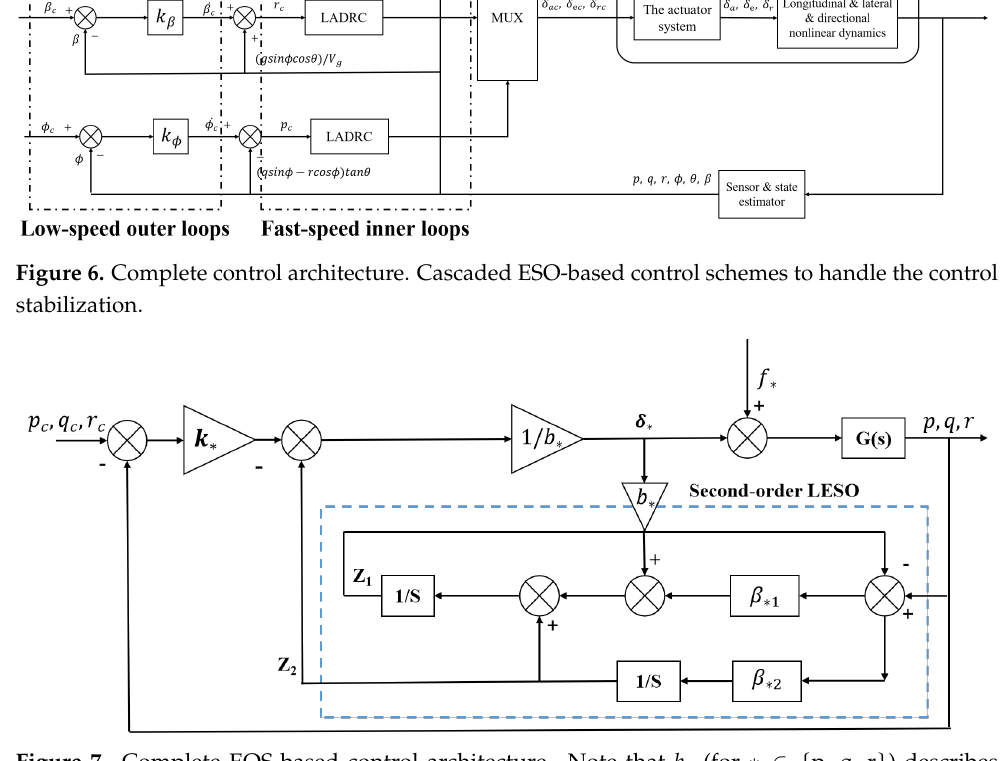
Figure 7. Complete EOS-based control architecture. Note that b ∗ (for ∗ ∈ { p, q, r } ) describes control efficiency related parameter. β ∗ 1 and β ∗ 2 (for ∗ ∈ { p, q, r } ) are ESO ralated parmeters. δ ∗ (for ∗ ∈ { a, e, r } ) is the actuator command. k ∗ (for ∗ ∈ { p, q, r } ) defines low-speed outer loop parameter. f ∗ (for ∗ ∈ { p, q, r } ) is lumped disturbance of angular rate